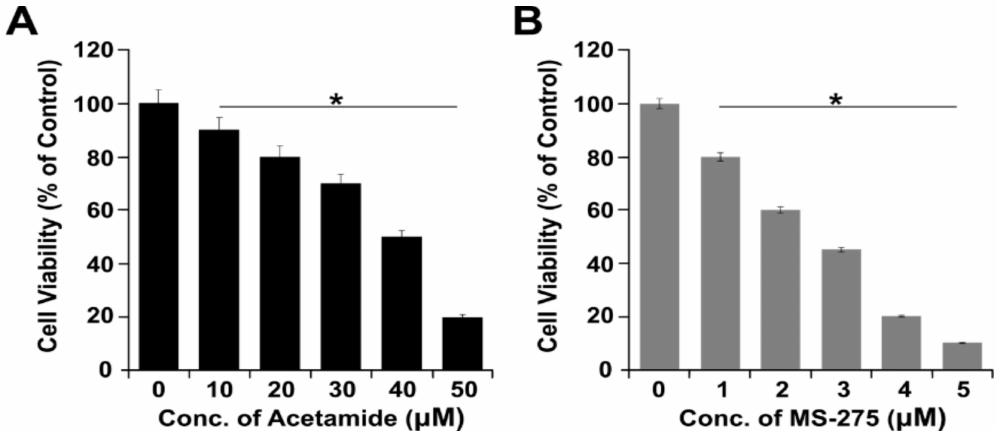
Figure 3. Dose-dependent effect of acetamide and MS-275 in A549 cells. ( A ) A549 cells were incubated with various concentrations of acetamide (10–50 µ M) for 24 h, and cell viability was measured using CCK-8. ( B ) A549 cells were incubated with various concentrations of MS-275 (1–5 µ M) for 24 h, and cell viability was measured using CCK-8. The results are expressed as the mean ± standard deviation of three separate experiments. Statistically significant differences between the treated and control group are indicated by (* p <